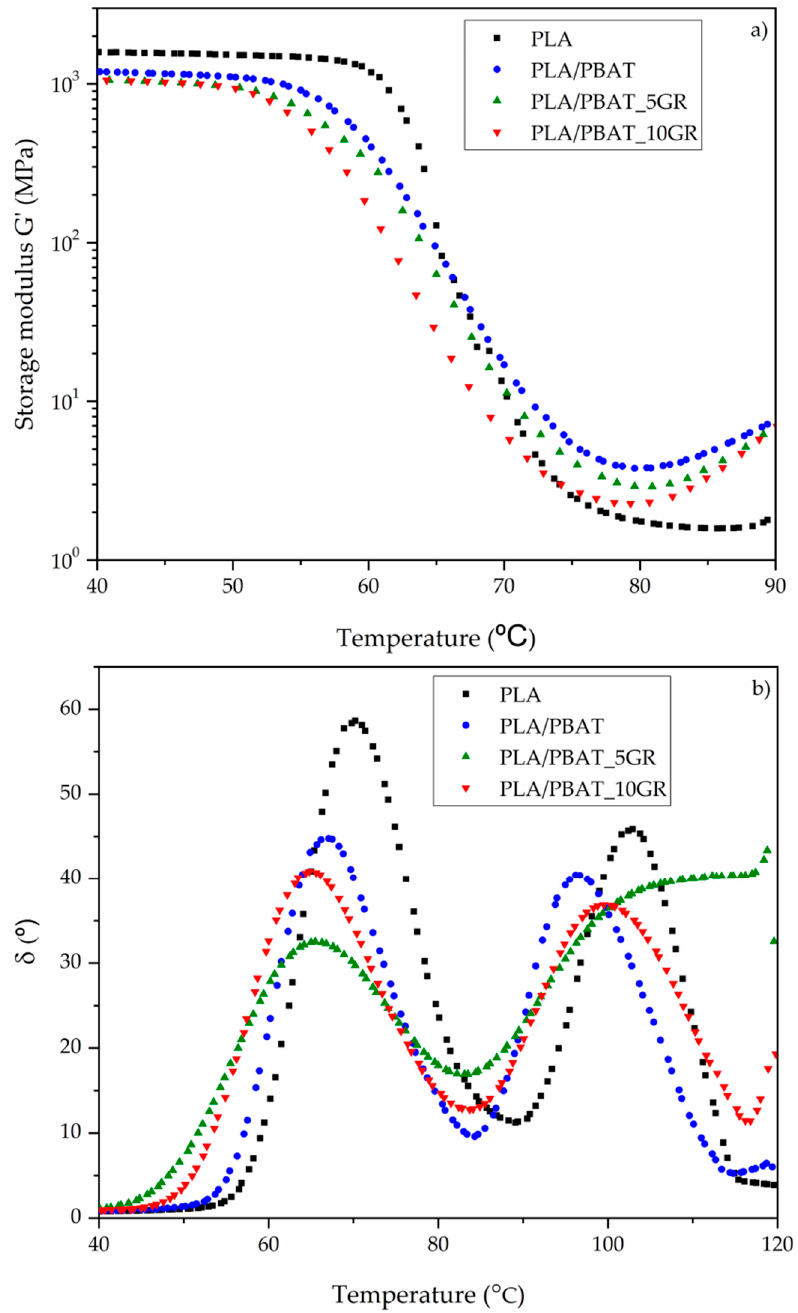
Figure 5. ( a ) Storage modulus (G’) and ( b ) loss factor ( δ ) of PLA and PLA/PBAT as references, and representatives PLA/PBAT formulations with 5 and 10 phr of GR.